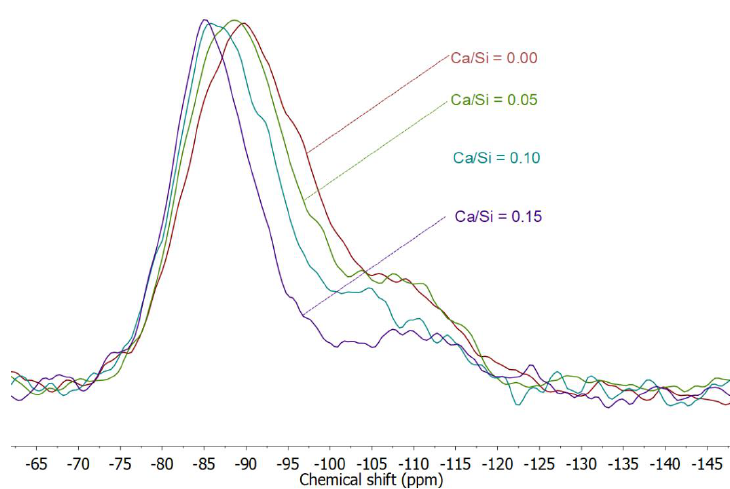
Figure 6. 29 Si NMR spectra of geopolymers at 7 days with different amounts of Ca.